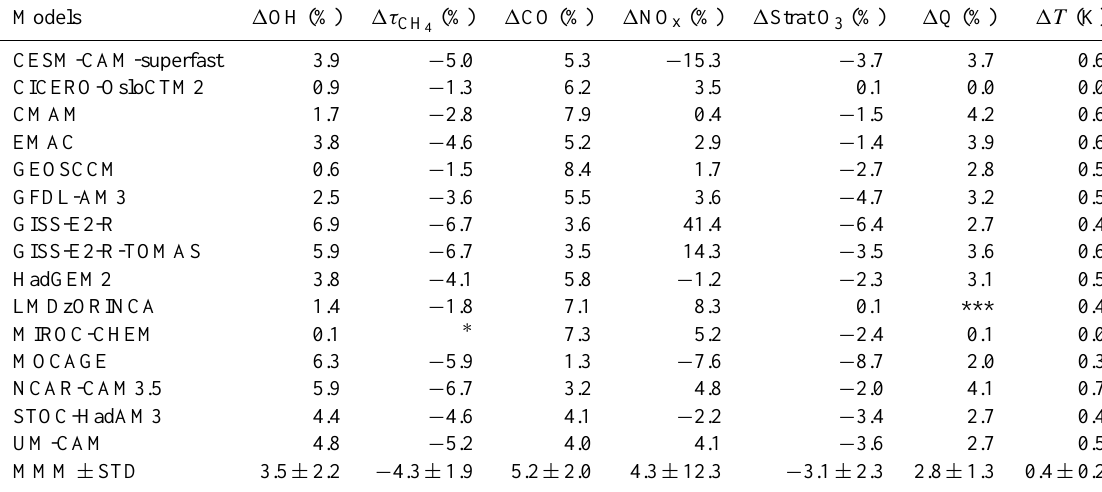
Table 5. Same as in Table 4 but for changes in present-day (2000) relative to 1980. Models